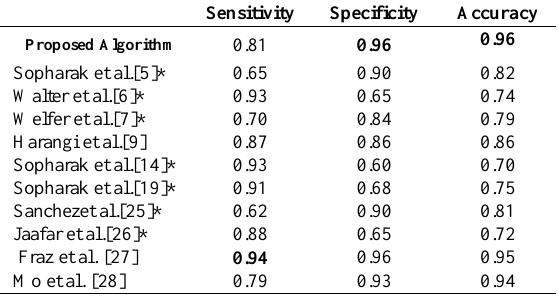
Table 1. The results of the proposed algorithm after the classification of the pixels as exudate and non-exudate.